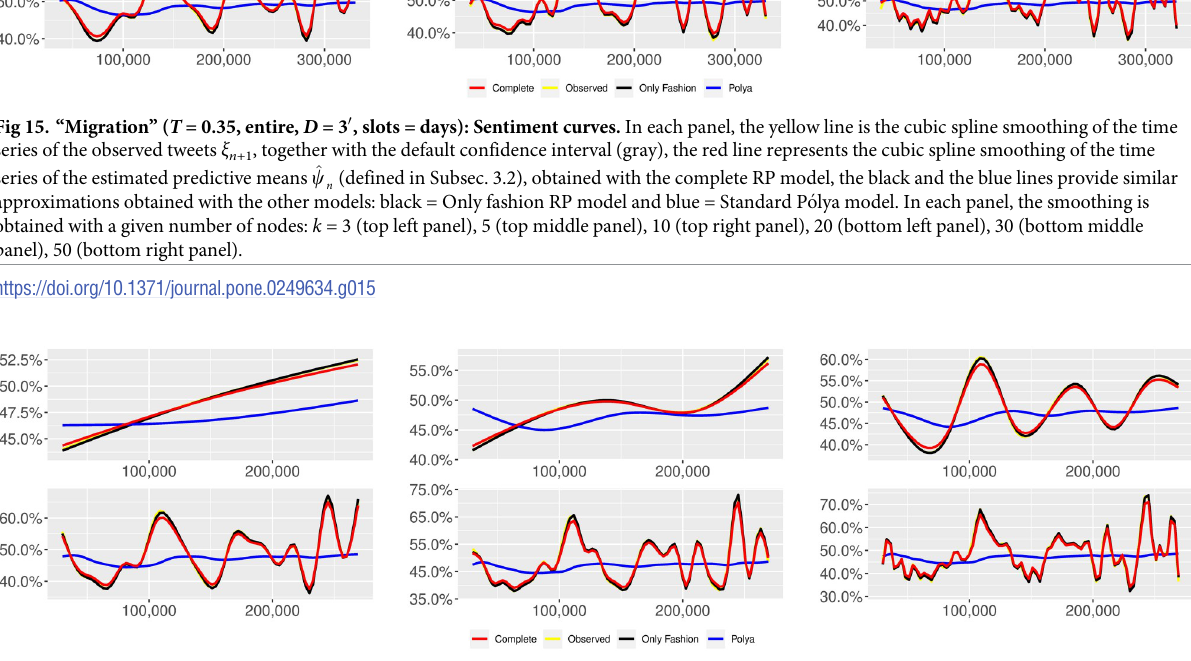
Fig 16. “Migration” ( T = 0.5, entire, D = 3 0 , slots = days): Sentiment curves. In each panel, the yellow line is the cubic spline smoothing of the time series of the observed tweets ξ n +1 , together with the default confidence interval (gray), the red line represents the cubic spline smoothing of the time series of the estimated predictive means ^ c (defined in Subsec. 3.2), obtained with the complete RP model, the black and the blue lines provide similar n approximations obtained with the other models: black = Only fashion RP model and blue = Standard Po´lya model. In each panel, the smoothing is obtained with a given number of nodes: k = 3 (top left panel), 5 (top middle panel), 10 (top right panel), 20 (bottom left panel), 30 (bottom middle panel), 50 (bottom right panel).